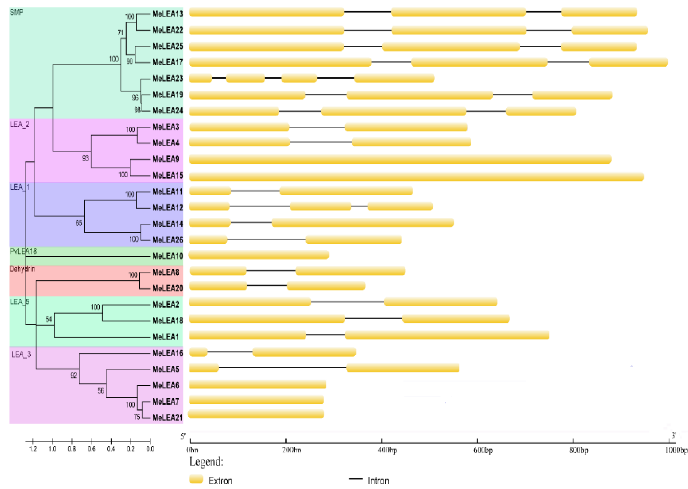
Figure 3. The exon-intron structure of the MeLEAs based on the evolutionary relationship. Exon-intron analysis of MeLEAs were performed with GSDS database. The back lines and the yellow boxes represent introns and exons, respectively.